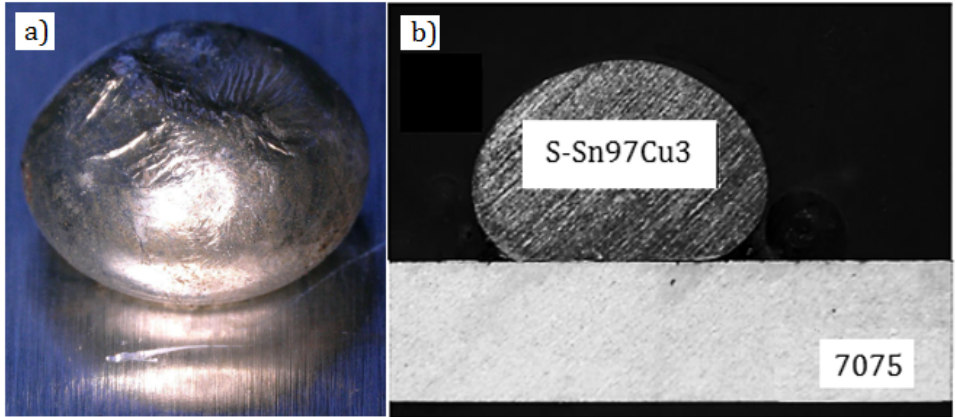
Figure 1. Lack of wettability of S-Sn97Cu3 filler metal on 7075 aluminum alloy substrate: general view ( a ) and cross section ( b ).